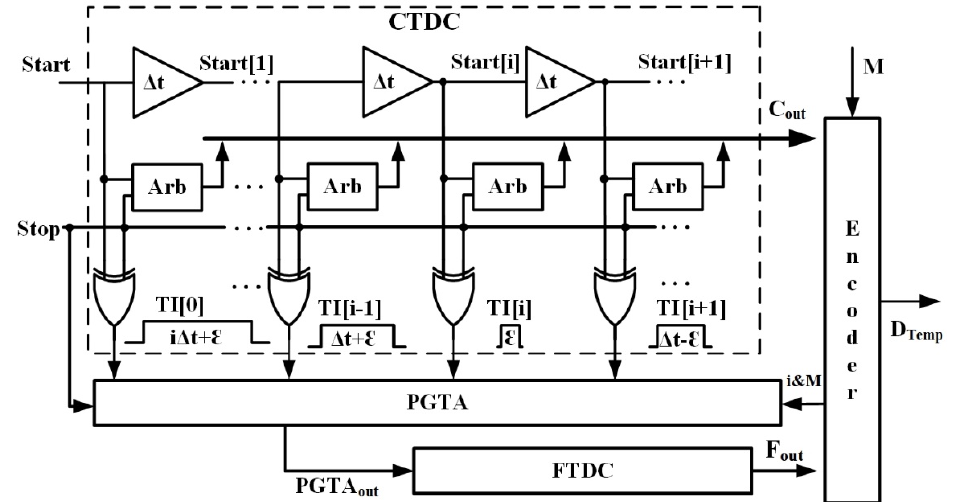
Figure 6. Structure of the pipeline TDC.